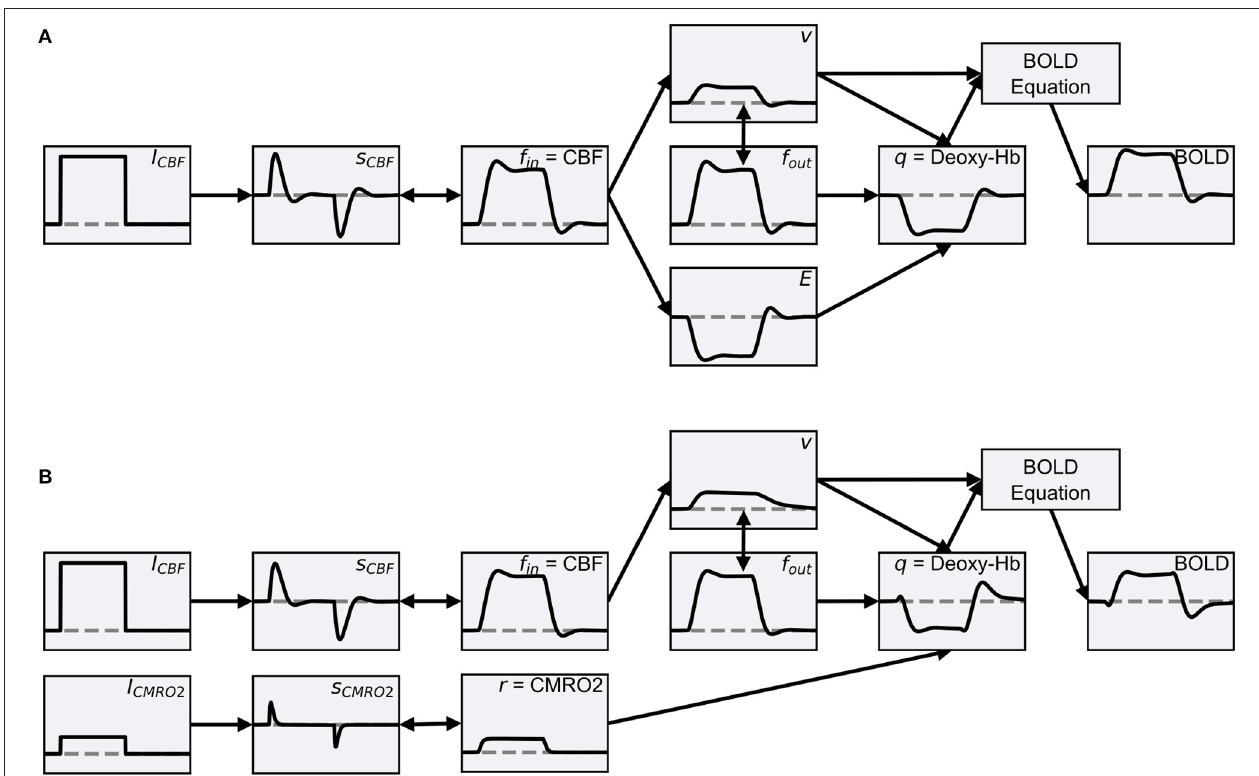
FIGURE 1 | (A) Schematic overview of the classic Balloon model (Buxton et al., 1998) with the neurovascular coupling extension of Friston et al. (2000). The data was simulated using ANNarchy’s default BOLD monitor which recorded a single artificial neuron, whose activity (the source variable for the BOLD monitor) was manually set. The activity of the neuron and thus the input signal ( I CBF ) were manually increased from zero to 0.2 for 20 s. The normalized CBF ( f in ) changes as a function of the CBF-driving signal ( s CBF ), which is subject to negative feedback from itself and f in . f in is coupled to the blood oxygen extraction fraction ( E ) and increases the normalized volume fraction of the venous compartment ( v ), which behaves like a balloon and decreases with outflowing blood ( f out ). The normalized total deoxyhemoglobin content ( q ) increases by oxygen extraction of inflowing blood and decreases with outflowing deoxyhemoglobin-containing blood. Finally, relative changes of the BOLD signal are calculated. The gray horizontal lines correspond to one for the quantities normalized to their baseline in the Balloon model ( f in , f out , v , q ). For I CBF , s CBF and BOLD the gray horizontal lines correspond to zero and for E to E 0 . (B) Balloon model with parallel driven CBF and CMRO2. Instead of coupling the increase in q with f in via E , the normalized CMRO2 ( r ) is used directly (see Buxton et al., 2004), which is driven by a second input signal ( I CMRO 2 ) like the normalized CBF (increased to 0.05 for 20 s). Further, f out is described by the equations of Buxton et al. (2004) which causes v to decrease slower. Besides these changes, the processes are the same as in (A) and the plots of the same quantities have the same limits in (A,B) . The equations of both models can be found in Supplementary Sections 2, 4.2